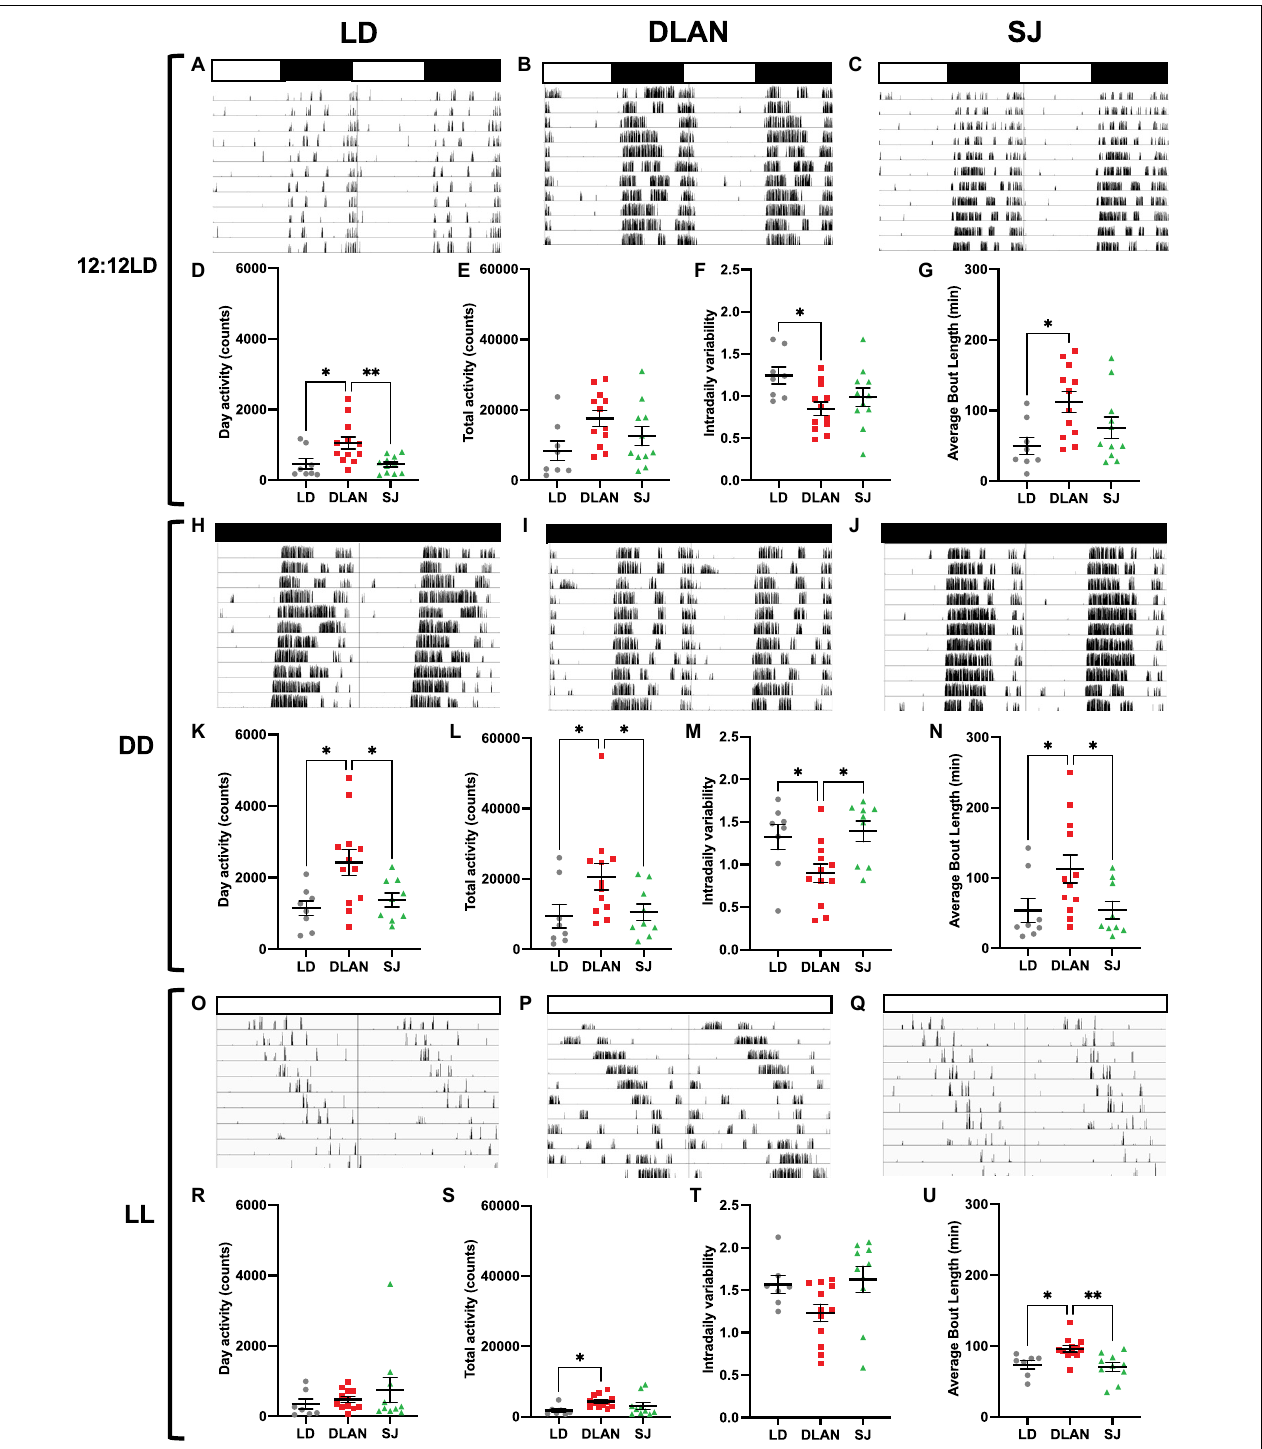
FIGURE 3 | Wheel running activity analysis under 12:12 LD, DD and LL, following the end of the 12-month lighting disruption period. Representative actograms for each lighting condition (listed vertically: 12:12LD, DD, LL) are shown for each group: LD (A,H,O) , DLAN (B,I,P) , and SJ (C,J,Q) (see Figure 1 for a description of the three groups). Data are double plotted to facilitate visualization. Variables were analyzed in the last 10 days of each condition, including (subjective) day activity counts (D,K,R) , total activity counts (E,L,S) , intradaily variability (F,M,T) and average bout length (G,N,U) . Individual data points represent independent mice and group means ± SEM are presented. One-way ANOVA (with Welch correction, or Kruskal-Wallis test when appropriate), groups: LD, DLAN, SJ. Post-hoc tests conducted with Benjamini-Hochberg corrections when appropriate. Supplementary Table 1 lists the mean ± SEM of all analyzed parameters. ∗∗ p < 0.01, ∗ p < 0.05.